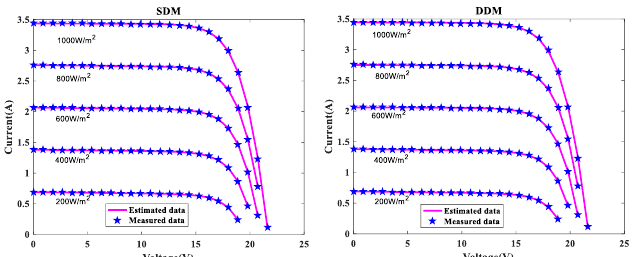
Figure 9. I-V characteristics for SM55 at various irradiances.